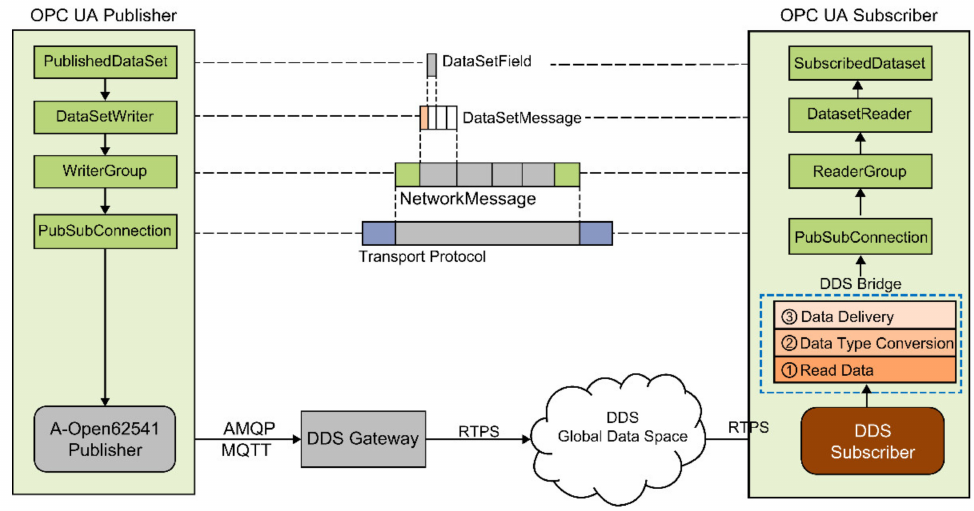
Figure 7. Communication model of OPC UA publisher and subscriber.